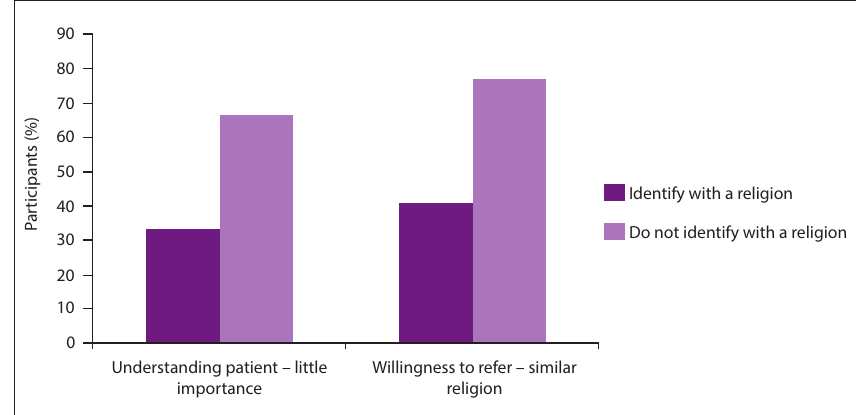
Fig. 1. Religious identification v. understanding patient and willingness to